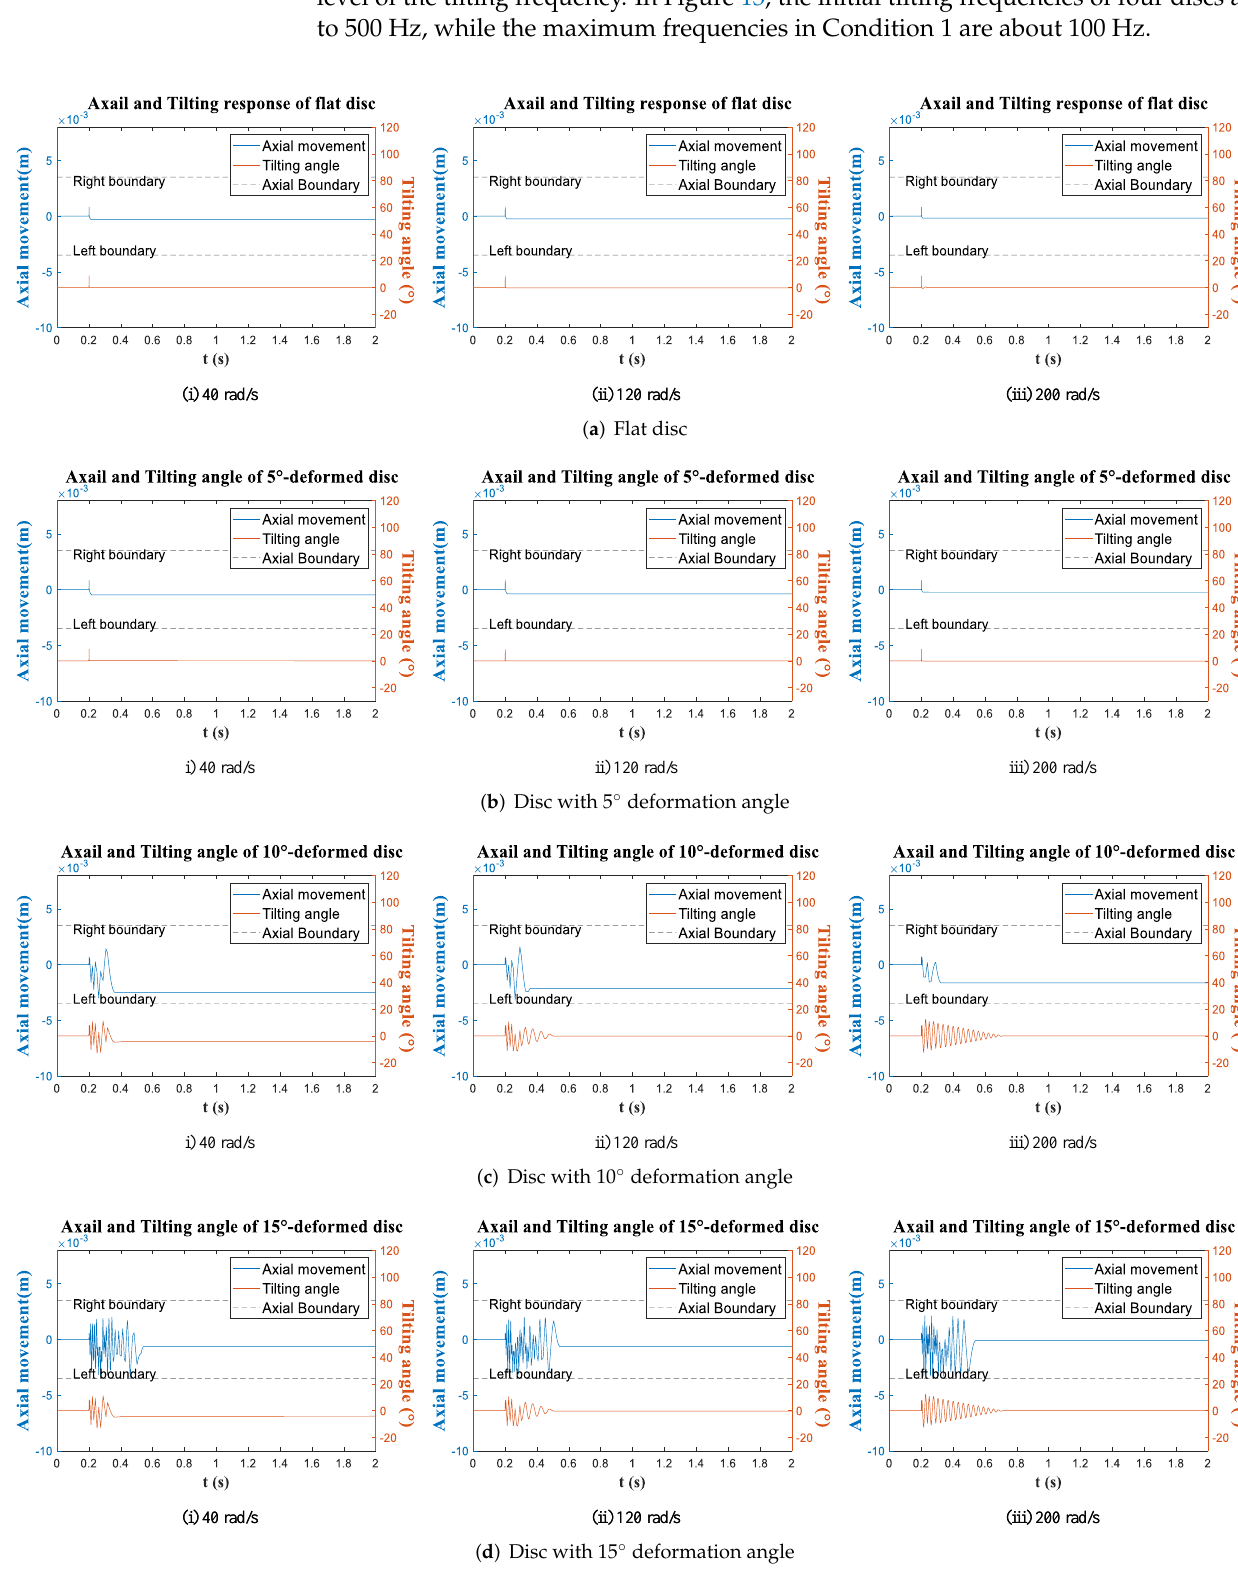
Figure 9. Time response: BC = 7 mm, initial force = 5